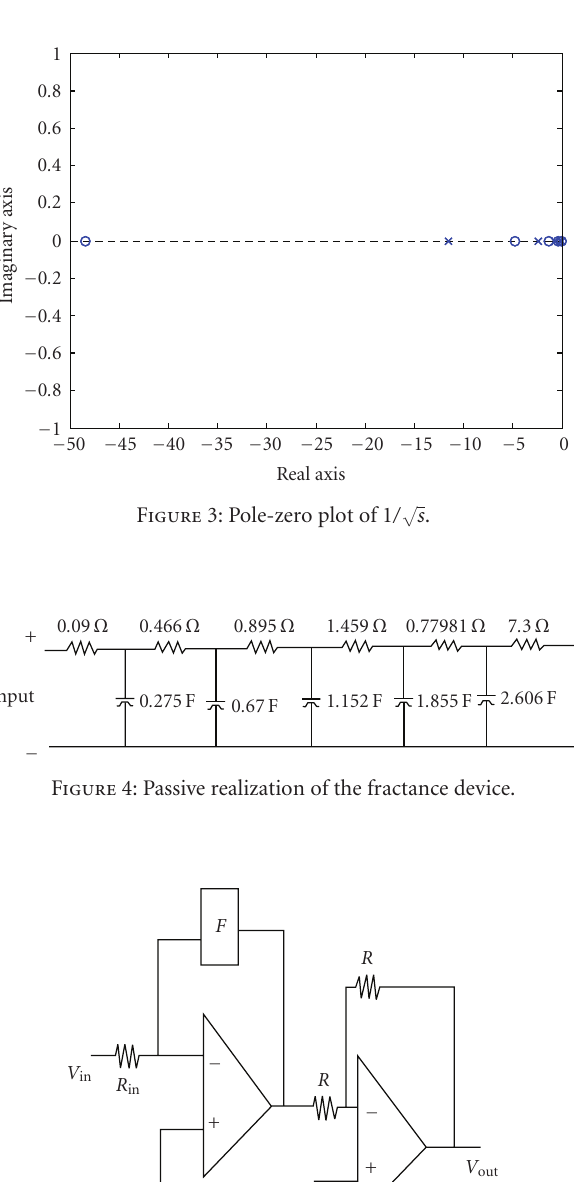
Figure 5: Active realization of the fractance device.